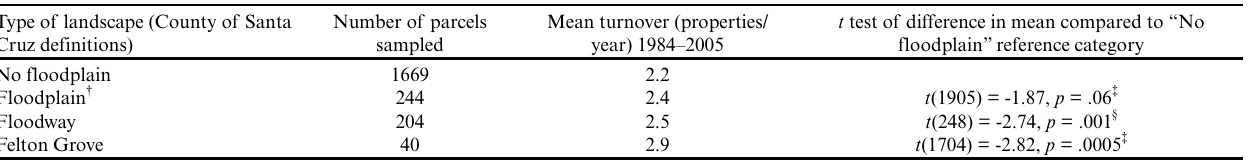
Table 3 . Homeowner turnover rates in Felton, California area (source: Santa Cruz County GIS) Type of landscape (County of Santa Cruz